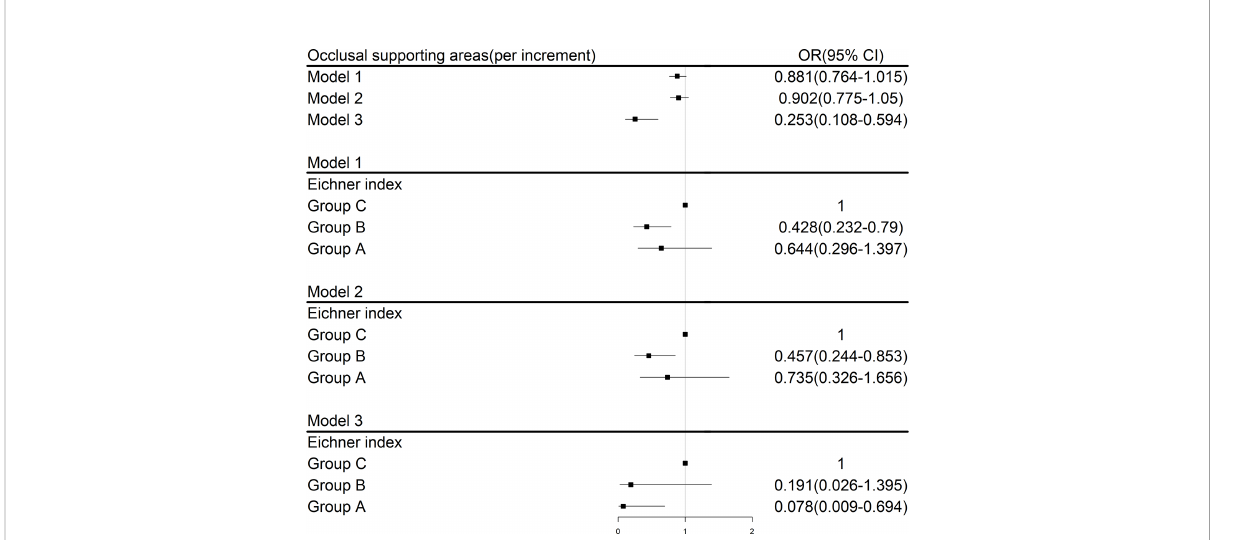
FIGURE 1 Logistic regression analysis for risk factors associated with type 2 diabetes; Group A:4 occlusal functional areas; Group B: 1-3 occlusal functional areas or 0 area with anterior occlusal contact; Group C: with no functional occlusal contact; Model 1:univariate; Model 2: adjusted for sex and age; Model 3: adjusted for age, sex, body mass index, education years, smoking and alcohol drinking, blood glucose, hypertension.